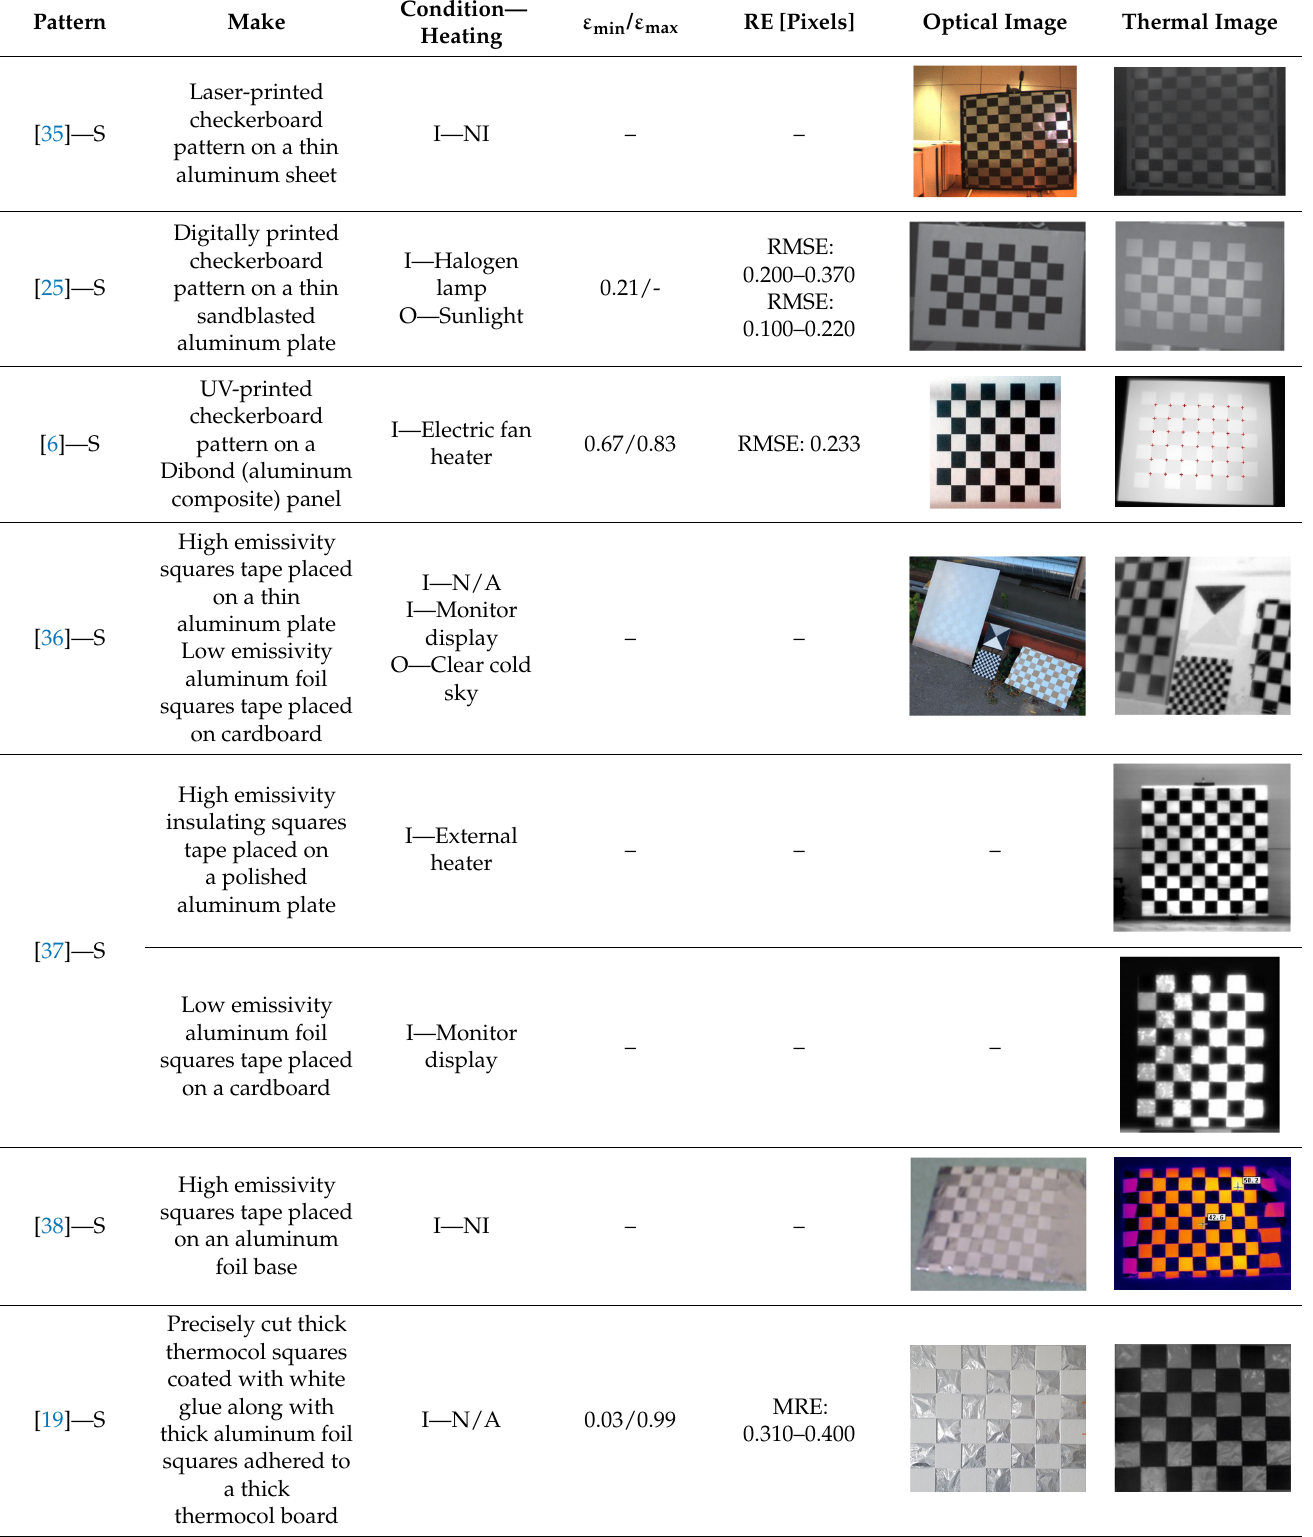
Painted black and white aluminum alloy squares I—Peltier module – MRE: 0.230 forming a checkerboard pattern and fixed to a wall